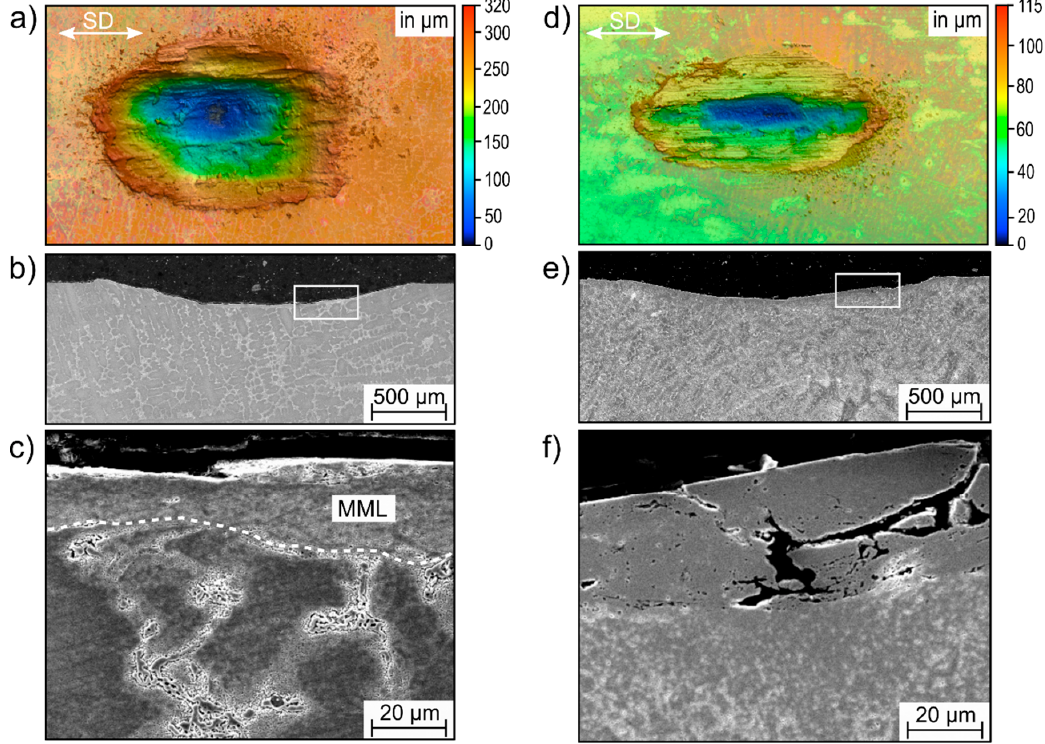
Figure 8. Wear track of the steel 1.4957 ( a – c ) and 5Mo-2W ( d – f ) in the top view ( a , b ; CLSM) and in the longitudinal section view ( b , e ; SEM-SE) according to Figure 2b,c including close-up views of certain subsurface areas ( c , f ); The arrows mark the sliding direction (SD).